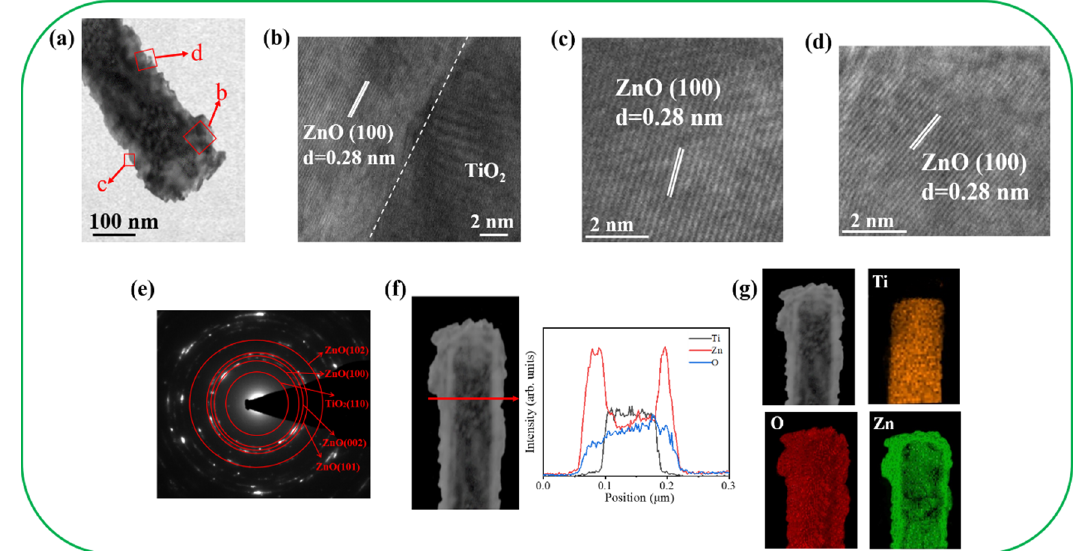
Figure 4. TEM analyses of TiO 2 − ZnO − C. ( a ) Low-magnification TEM image. ( b – d ) HRTEM images taken from various regions of the sample. ( e ) Selected area electron diffraction (SAED) pattern taken from several composite nanostructures. ( f ) EDS line-scanning profiles across the sample. ( g ) Element mapping images of the sample.